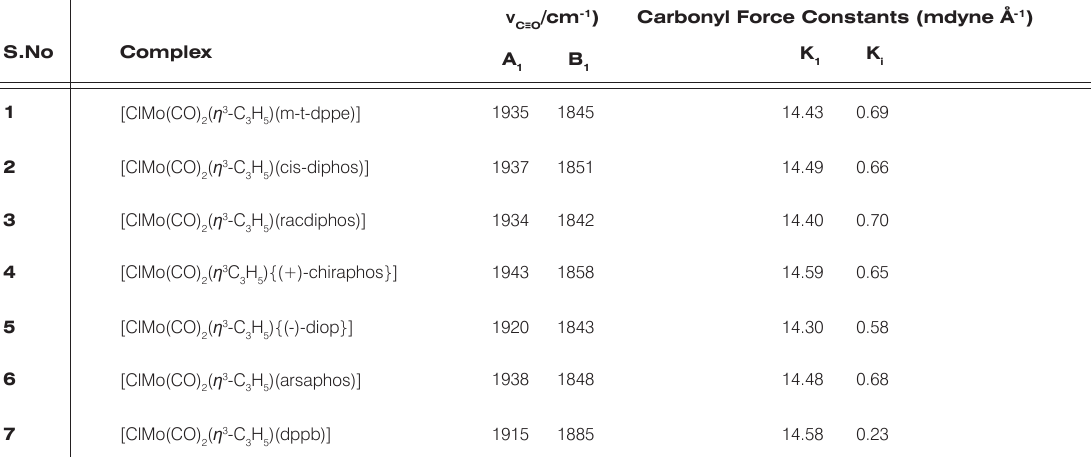
( η 3 -C H )(P-P)]. 2 3 5